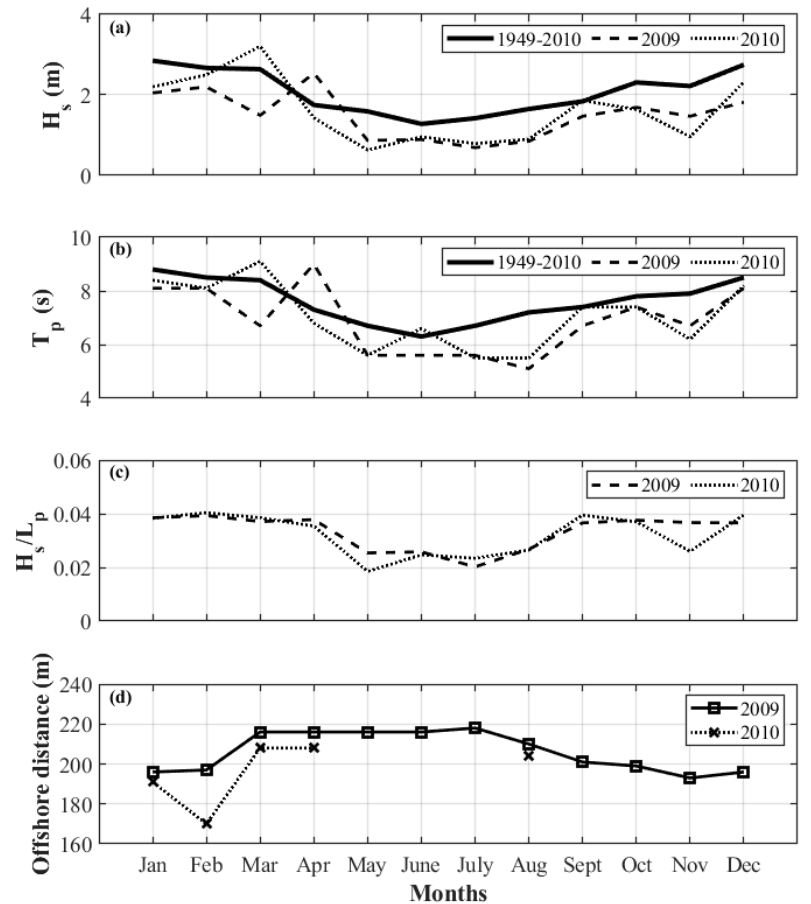
Figure 4. Intra-annual variations of: ( a , b ) monthly Q99 of significant wave heights Hs and peak periods Tp for 2009–2010 vs. annual monthly Q99 of the same parameters for 1948–2010 at depth 17 m; ( c ) wave steepness of transformed monthly Q99 waves for 2009–2010 at depth 4.4 m; ( d ) average monthly positions of the outer bar crests for 2009–2010.